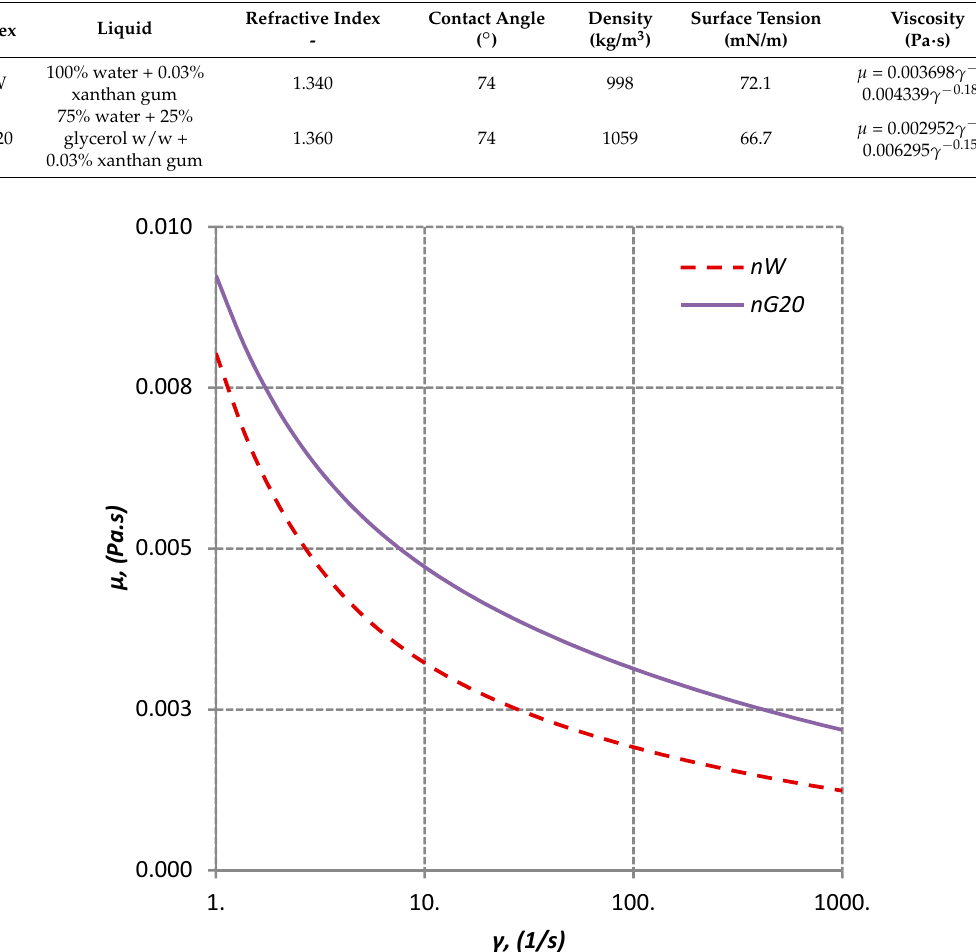
Table 1. Physical properties of liquids used.